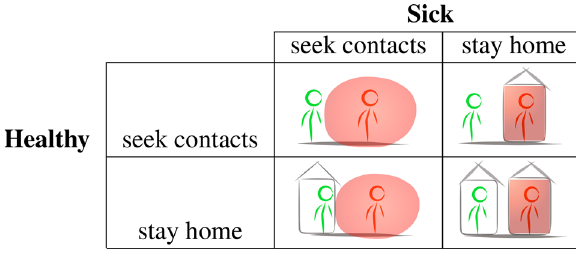
Figure 1. The social distancing interactions simplified.